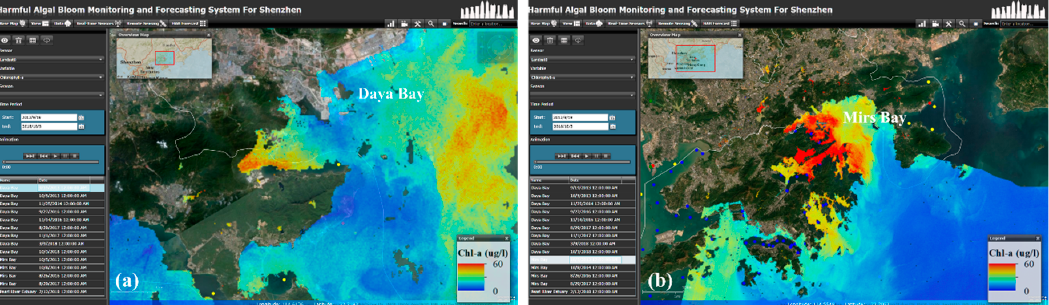
Figure 8. Chl-a concentration map of the harmful algal bloom (HAB)-affected areas using the support vector regression model: ( a ) HAB occurred on 25 November 2014 in the Daya Bay; and ( b ) HAB occurred on 29 August 2017 in the Mirs Bay.